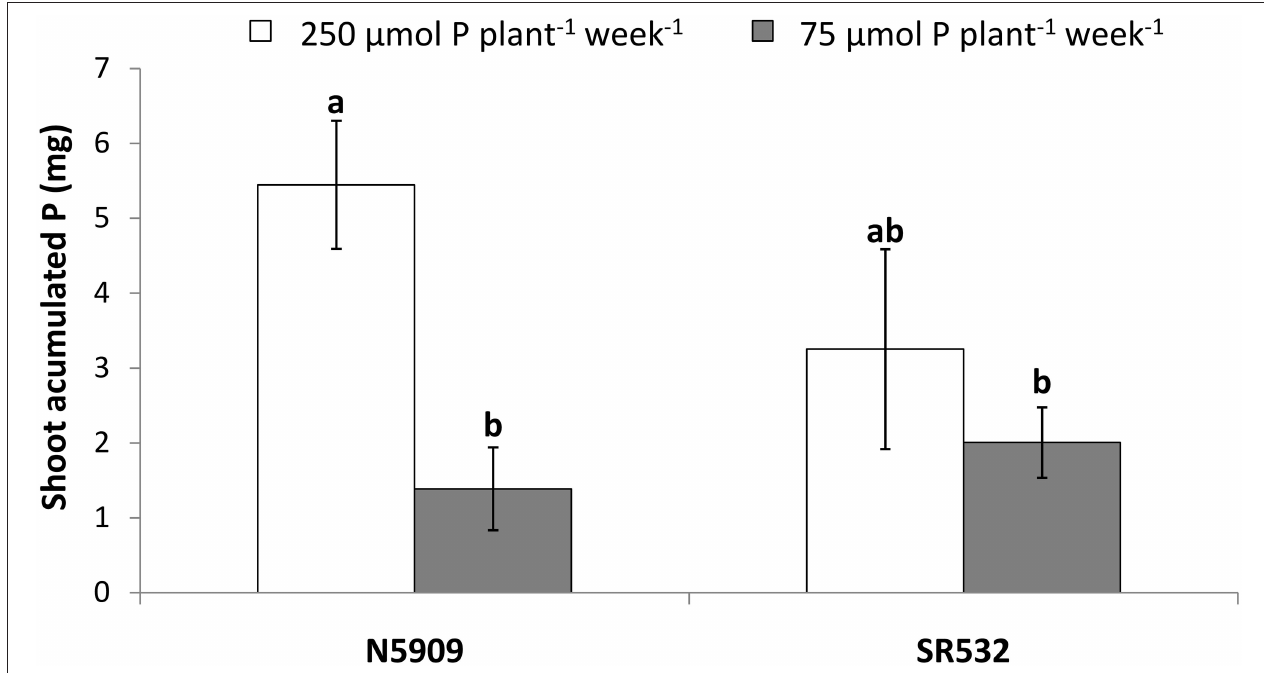
FIGURE 4 | Shoot accumulated phosphorus in G. max cultivars N5909 and SR532 inoculated with B. elkanii SEMIA 587 under P sufficiency (250 µ mol P plant − 1 week − 1 ) (white) vs. P deficiency (75 µ mol P plant − 1 week − 1 ) (gray). Data represent average and standard deviation of ten replicates harvested at 42 DAT. Treatments with a common letter are not significantly different ( p >